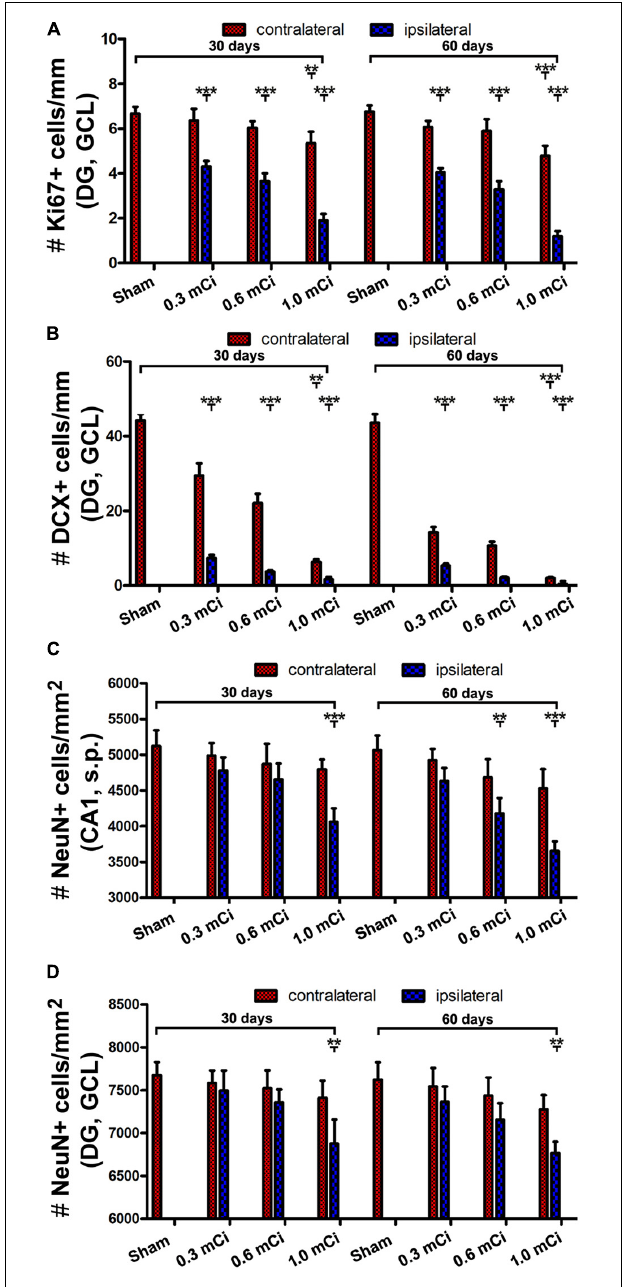
FIGURE 6 | Quantification of Ki67, DCX + and NeuN + cells in ipsilateral and contralateral hippocampi in the radiated relative to sham control. The numeric densities of Ki67 + and DCX + cells are expressed as number (#) of cells per mm of the GCL length of DG, NeuN + cells, expressed as number (#) of cells per mm 2 of the GCL and the stratum pyramidale (s.p.) of CA1 in the dorsal hippocampus in each groups. (A,B) Plot the mean densities of Ki67 + and DCX + cells in the ipsilateral and contralateral sides in the sham group, and the groups with radiation after survival for 30 and 60 days, as indicated. (C,D) Illustrate the densities of NeuN + cells in the GCL and the s.p. in CA1 in the control and radiation groups. Abbreviations are as defined in Figure 2 . All data are represented as mean ± SD. Statistical analysis results are as indicated ** p < 0.01 compared with sham, *** p < 0.001 compared with